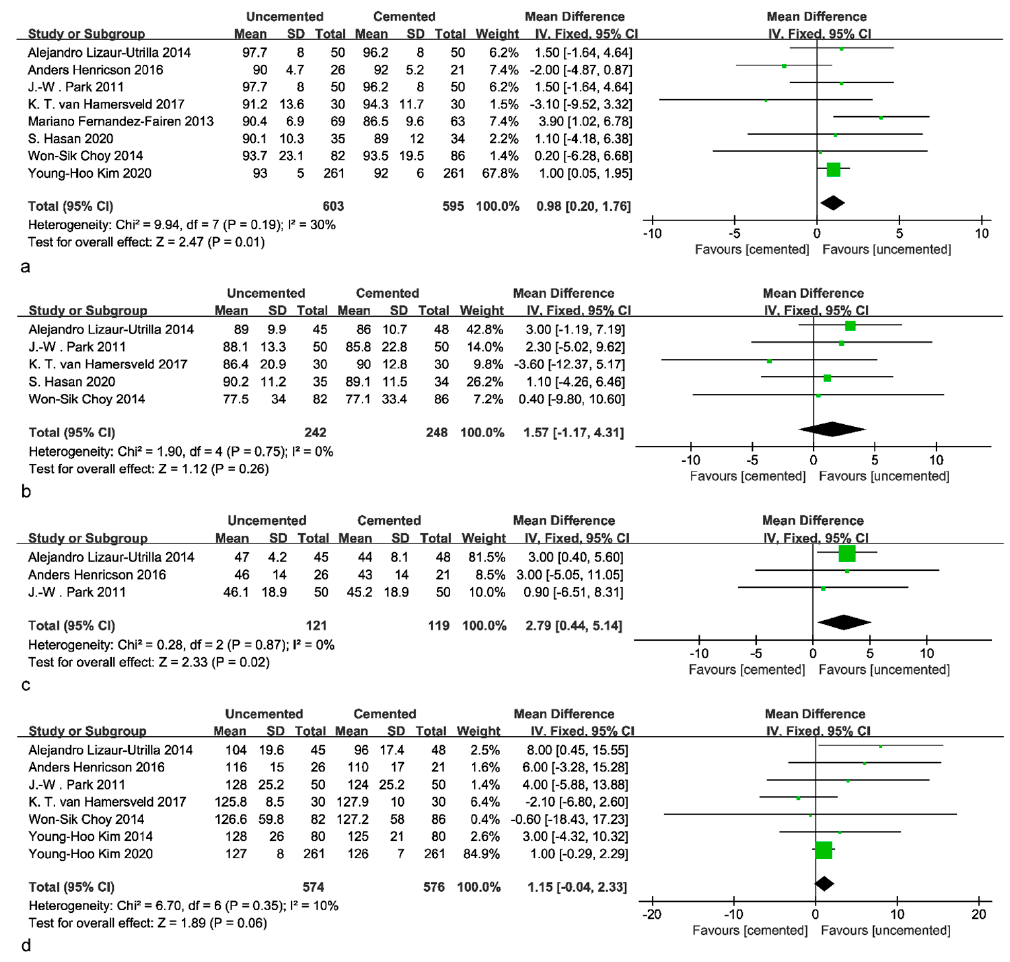
Figure 3. Forest plot of KSS and ROM. ( a ) Forest plot of KSKS [23–30]. ( b ) Forest plot of KSFS [23,25,28–30]. ( c ) Forest plot of KSS–Pain [26,28,29]. ( d ) Forest plot of ROM [23,26–31].